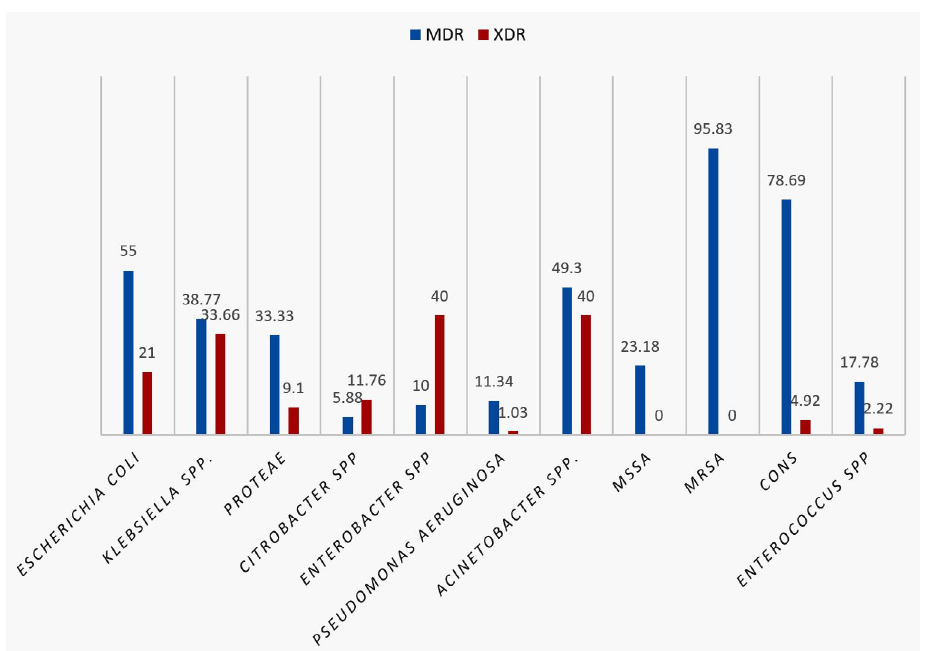
Fig. 5. Percentage prevalence of Multidrug resistant (MDR) and extended drug resistant (EDR) strains among various organisms